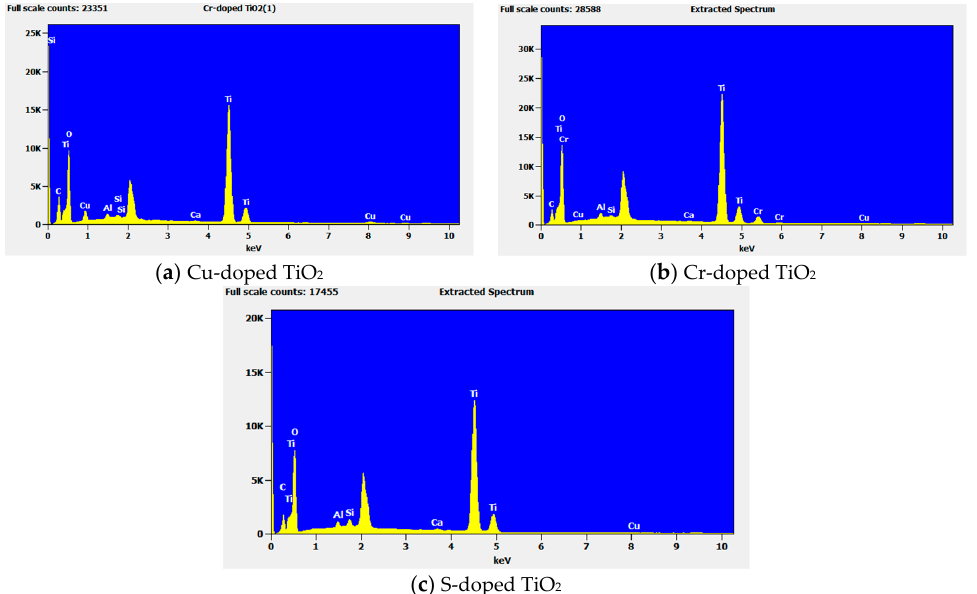
Figure 11. EDS (Energy dispersive spectroscopy) spectrum of doped TiO 2 specimens.